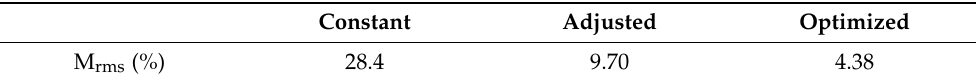
Figure 11. Distribution of NH 3 /NO around the flow passage for the parabolic profile. ( a ) Constant injection; ( b ) adjusted injec- tion; ( c ) optimized injection.